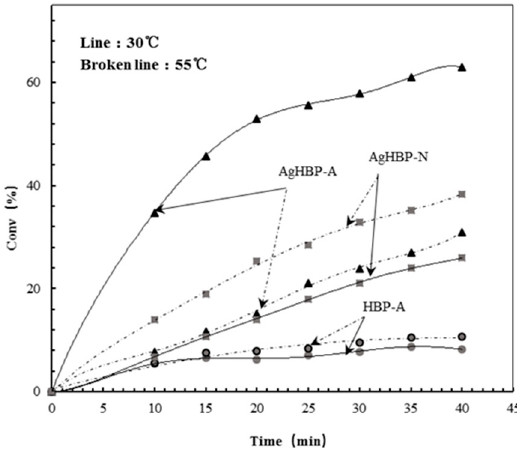
Figure 7. Reactivity of the prepared polymer reactors for the reduction of MB.